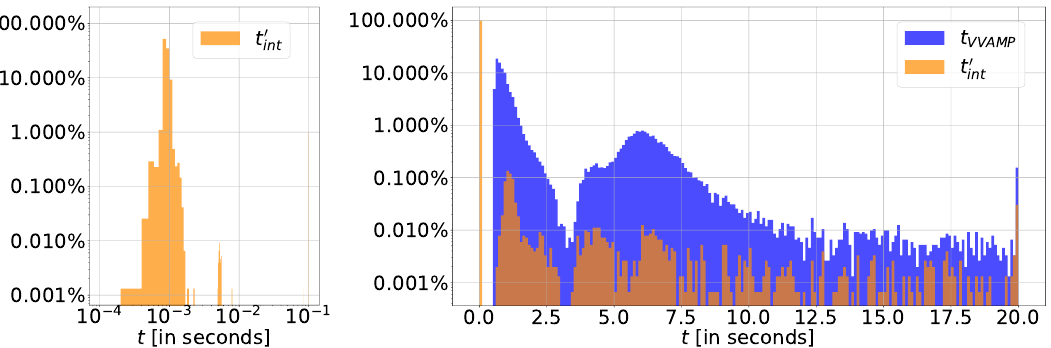
Figure 5. Distributions in the evaluation time t The last bin accounts for overflow ( t distribution in double logarithmic